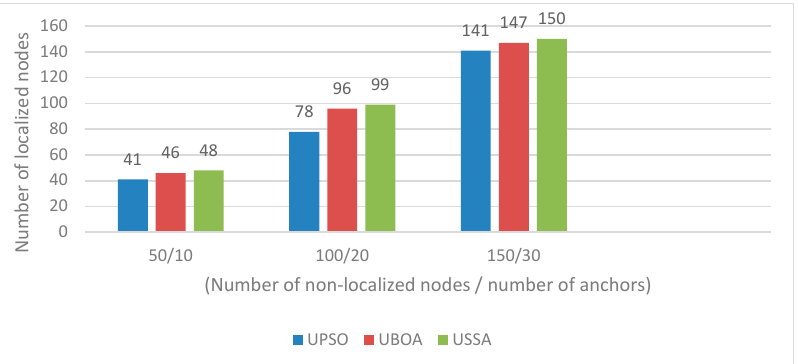
Figure 6. The number of localized nodes of the various localization algorithms in multiple UWSN deployments.